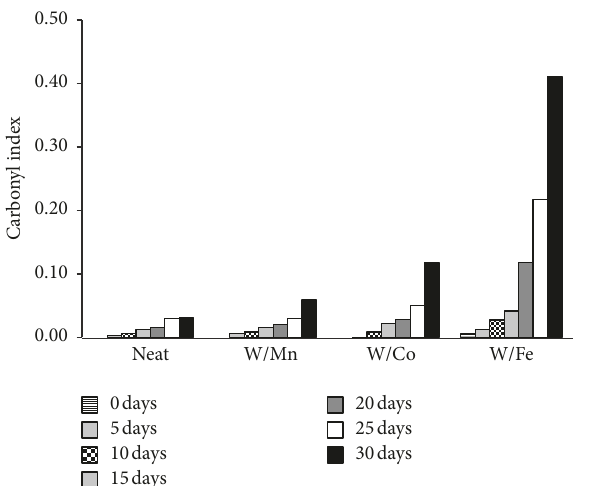
Figure 7: Increase in the carbonyl index of Apel 6509 COC neat and formulated films during exposure to QUV irradiation.